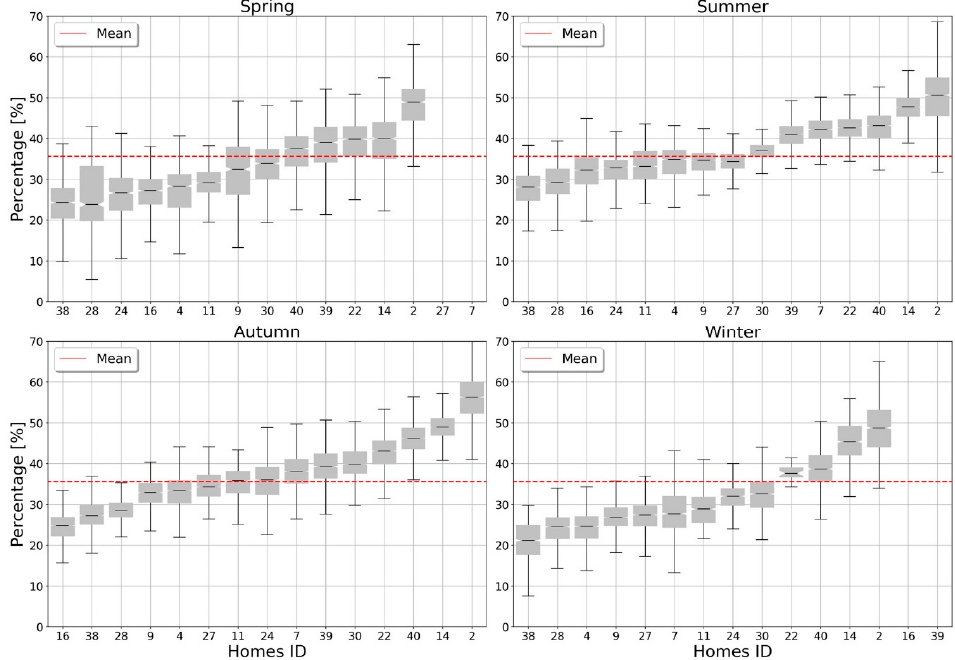
Figure 8. Ranked living room relative humidity by season. The red do tt ed line represents the